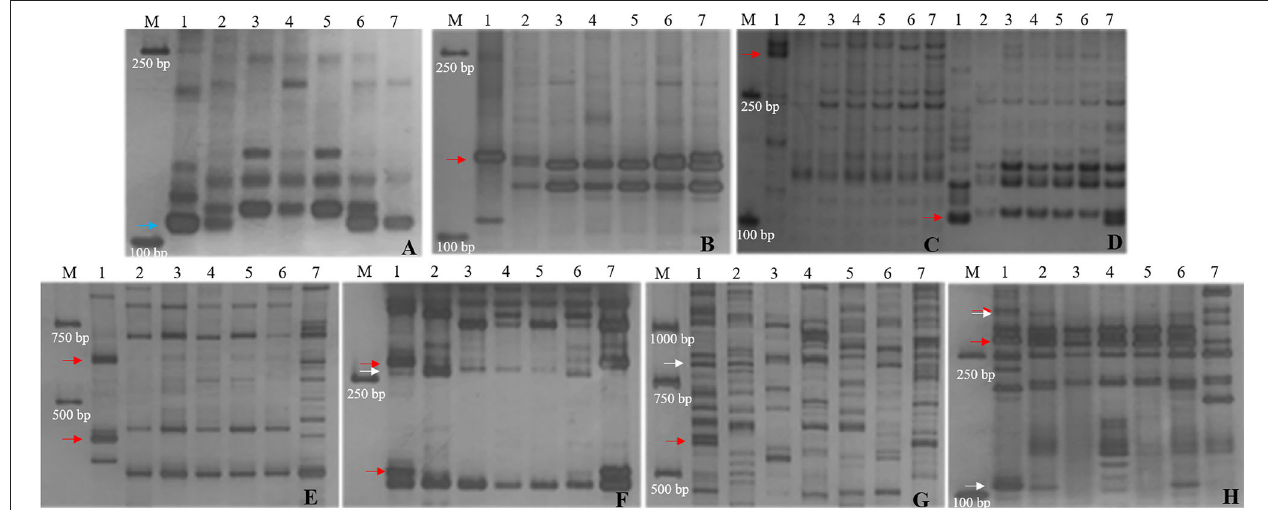
FIGURE 4 | Molecular marker analysis of SN19747 and CH10A5 (specific markers in CH10A5). (A) Xcfd63. (B) TNAC1044-HaeIII. (C) Xwmc432. (D) Xwmc93. (E) HaeIII-TNAC1088. (F) TNAC1021-TaqI. (G) BG313767. (H) TNAC1026-HaeIII. Lanes: M, DL2000; 1-7 refer to Th. ponticum , SNTE20, SNF63, YN15, JM22, SN19647 and CH10A5, respectively. The blue, red and white arrows indicate the bands shared between SN19647 and CH10A5, specific to CH10A5 and SN19647, respectively.